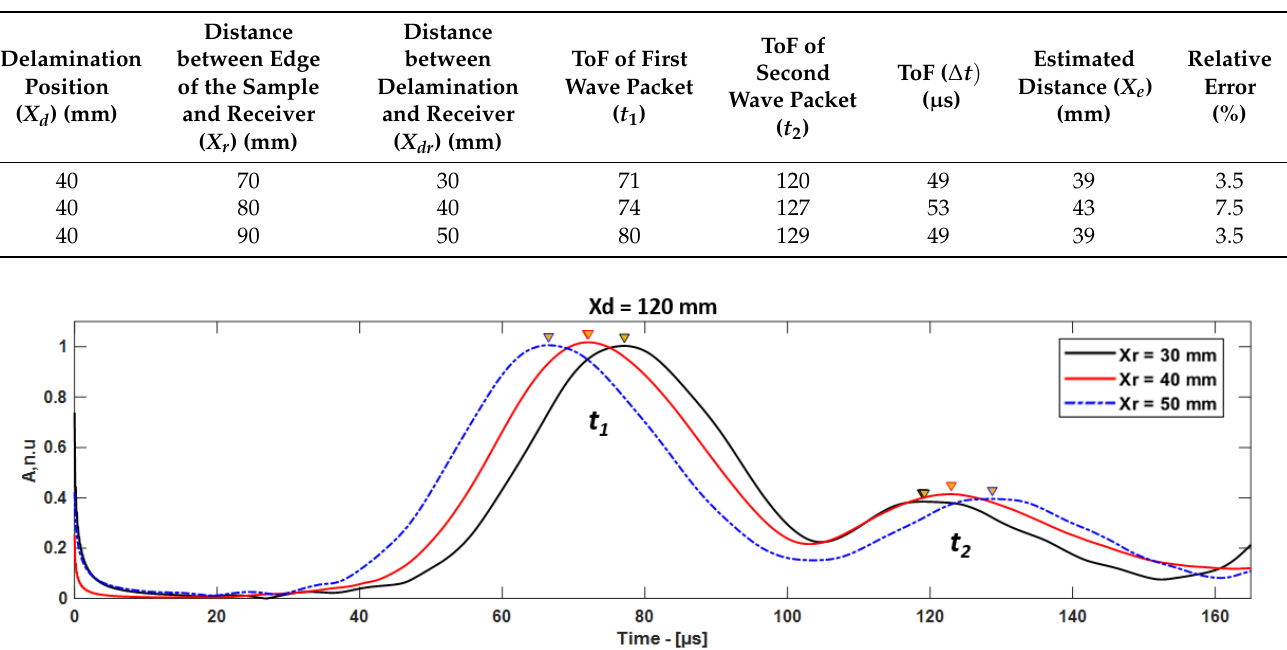
Table 4. The localization of delamination at 40 mm using different receivers.